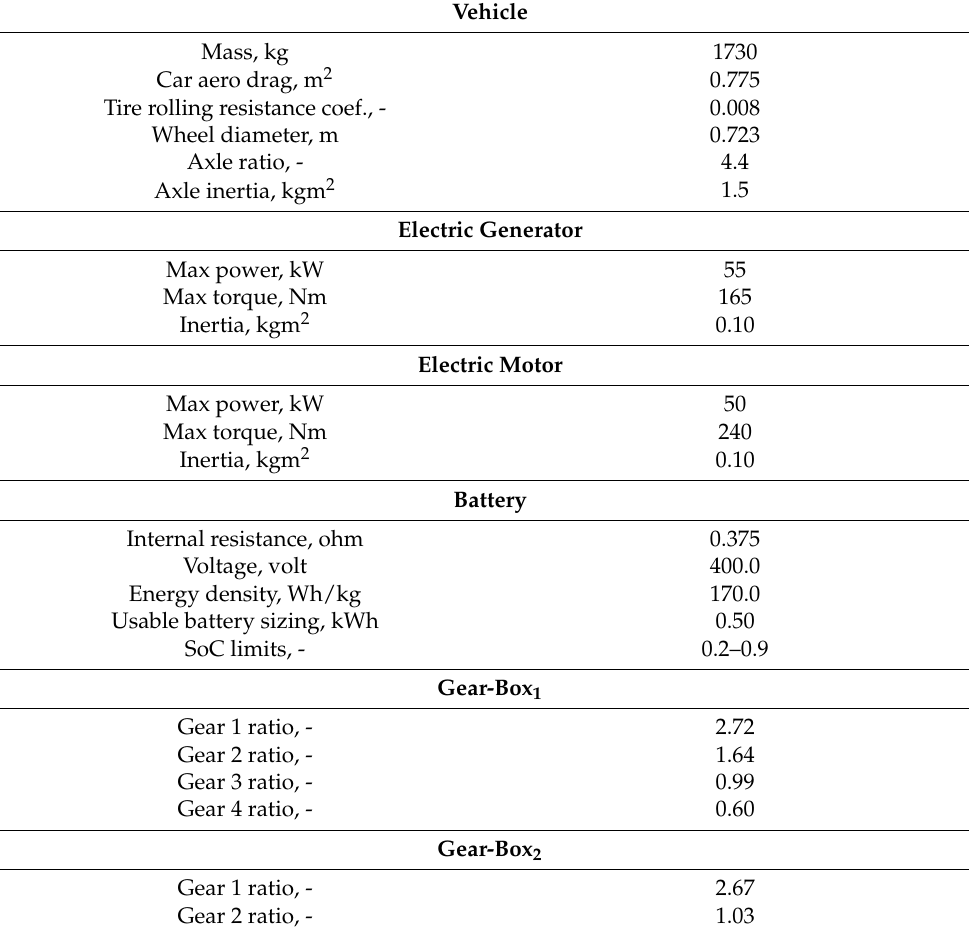
Table 1. Main characteristics of the tested HEV.